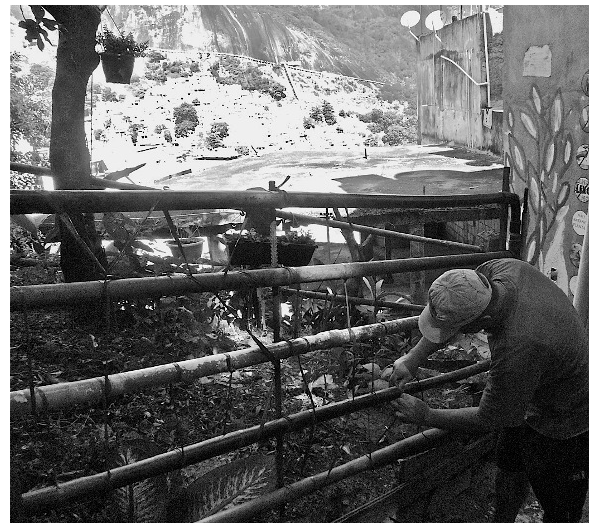
Figure 9. Resident creating a trellis on the fence at the Pedac- inho da Terra garden in the Cachopa neighborhood of